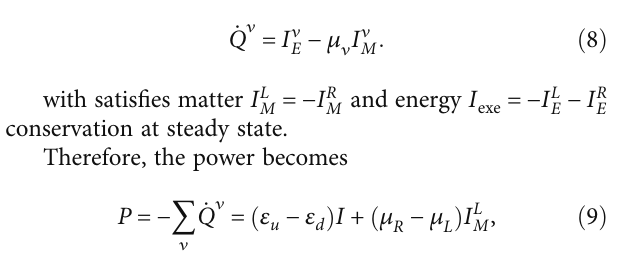
Figure 1: The model of a stochastically driven quantum dot heat engine. The arrows show all possible